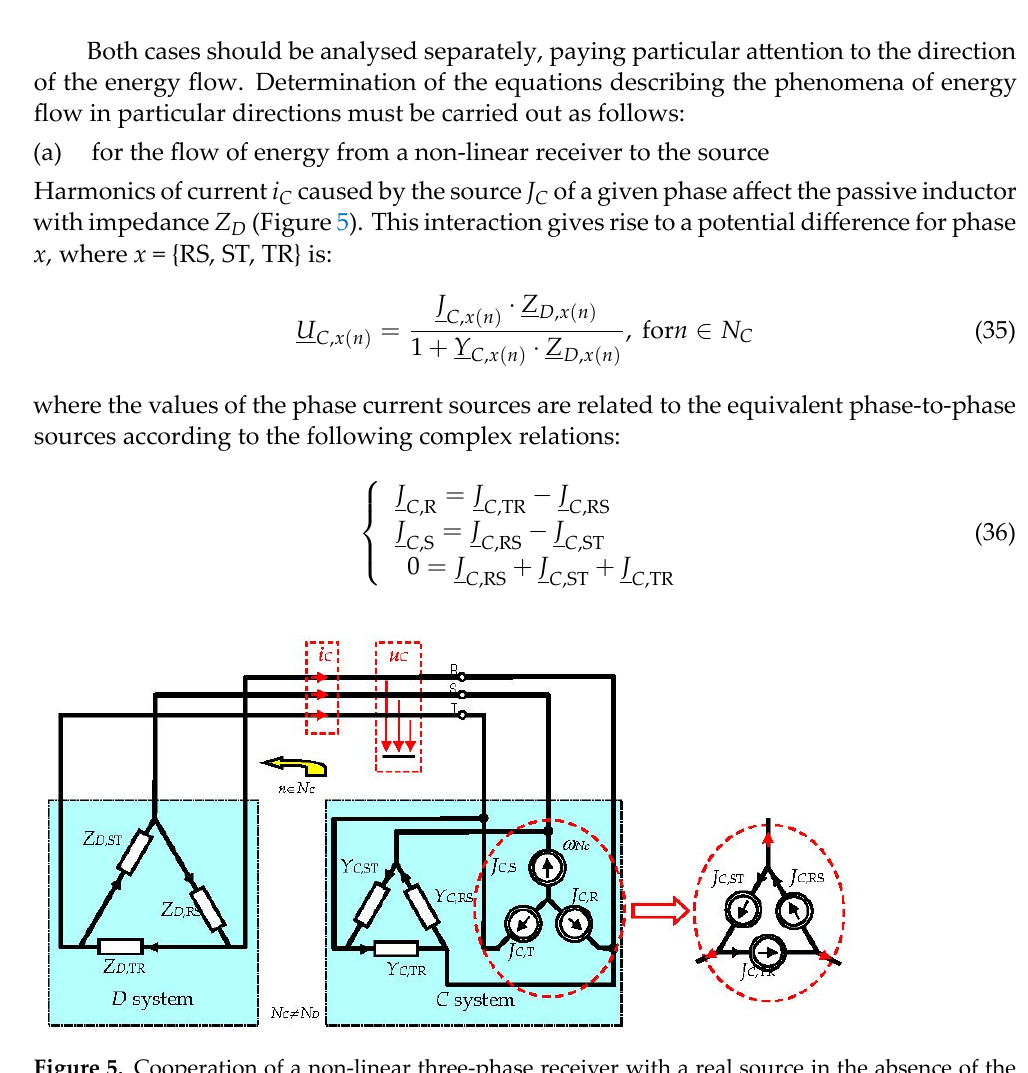
Figure 5. Cooperation of a non-linear three-phase receiver with a real source in the absence of the same harmonics in E D and J C sources. Energy flow from C to D system.